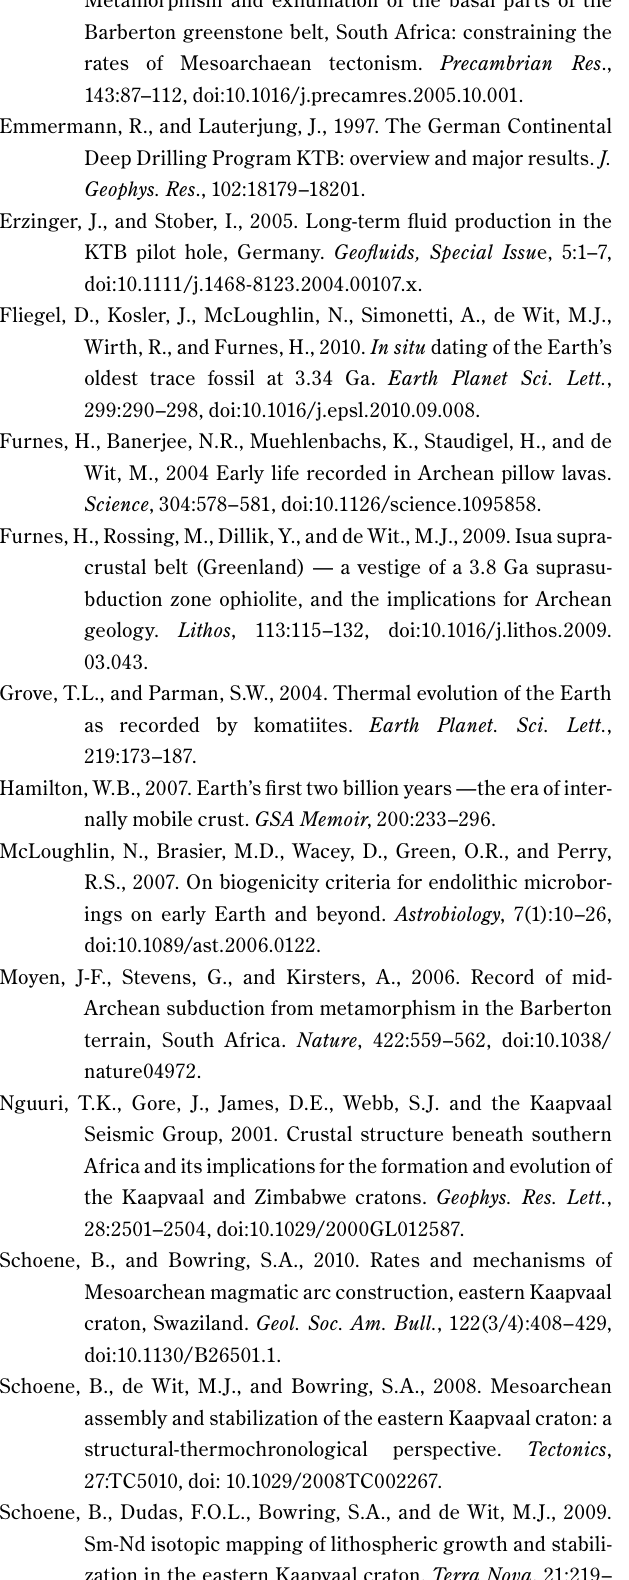
Fig. 1: Moctar Doucouré, AEON, University of Cape Town Fig. 3b, 3c: Dr. Ute Weckmann, GFZ-Potsdam,